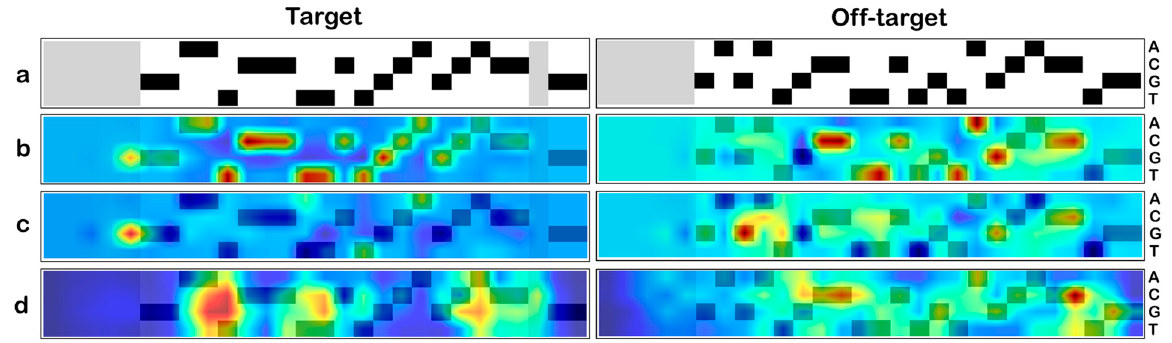
Figure 5. Activation maps (AMs). ( a ) The FANCF locus target and representative positive off-target